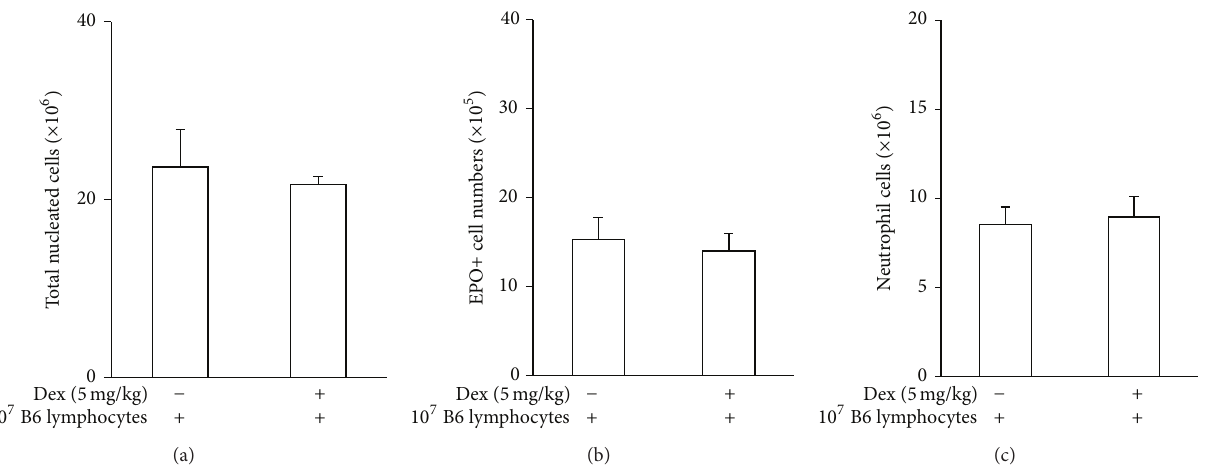
Figure 6: The transfer of splenic lymphocytes from a Pfp donor to a Pfp recipient fails to restore responses to dexamethasone. Data are Mean + SEM of total nucleated cell (a), EPO+ cell (b), and neutrophil (c) counts in freshly harvested bone-marrow of Pfp mice which had received 10 7 total nylon-wool purified Pfp lymphocytes, i.v., 48h before dexamethasone (5 mg/kg) injection. For both saline-injected and dexamethasone injected mice, 𝑛 = 3